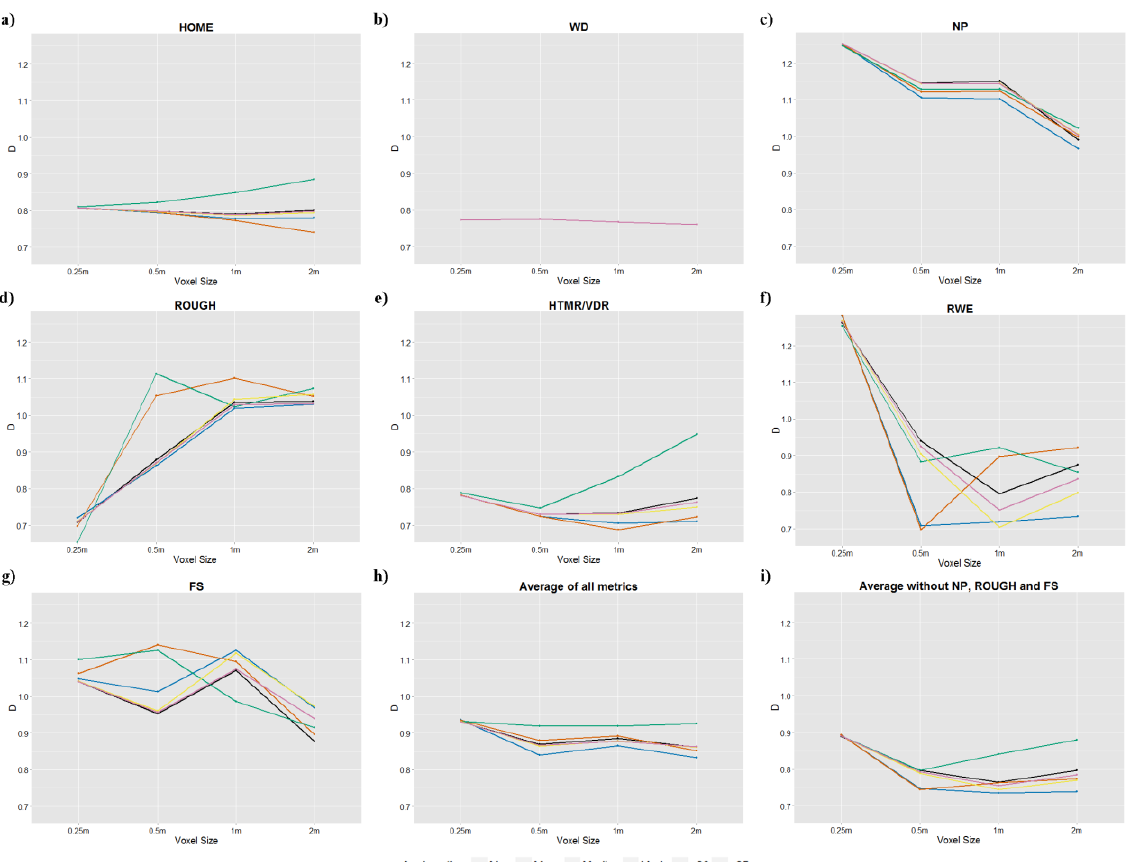
Figure 5. Graphs displaying the average of differences between standardised paired samples for each LiDAR full-waveform metric: ( a ) HOME, ( b ) WD, ( c ) NP, ( d ) ROUGH, ( e ) HTMR/VDR, ( f ) RWE, ( g ) FS, ( h ) average of all metrics differences between standardised paired samples for each testing set, ( i ) represents the same as h ) but without including NP, ROUGH and FS